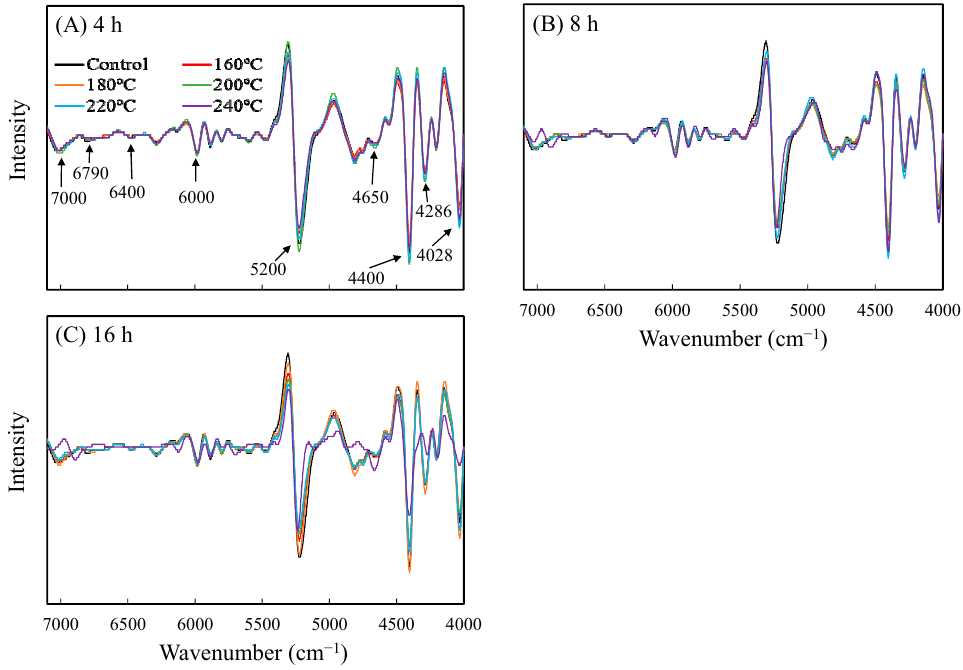
Figure 3. NIR spectra preprocessed by the second derivative combined with SG of luanta fir wood after VH treatment at different temperatures for 4 ( A ), 8 ( B ), and 16 h ( C ).